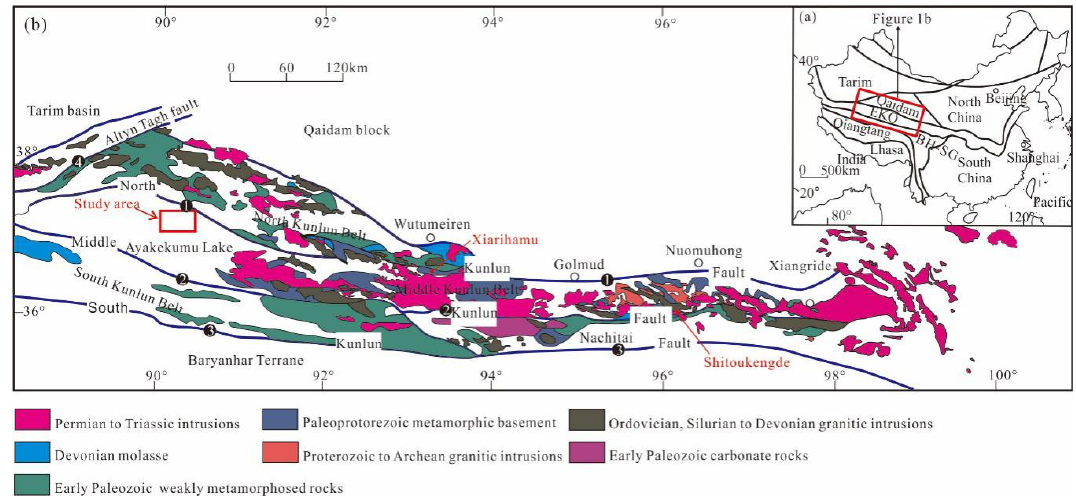
Figure 1. ( a ) Tectonic sketch map of China (revised after Yuan et al. [2]); ( b ) schematic geological map Figure 1. (a) Tectonic sketch map of China (revised after Yuan et al. [2]); (b) schematic geological map of the Eastern Kunlun Orogen (simplified after Xu et al. [3]). (cid:182) -North Kunlun fault; (cid:183) -Middle Kunlun of the Eastern Kunlun Orogen (simplified after Xu et al. [3]). ❶ -North Kunlun fault; ❷ -Middle fault; (cid:184) -South Kunlun fault; (cid:185) -Altyn Tagh Kunlun fault; ❸ -South Kunlun fault; ❹ -Altyn Tagh fault.